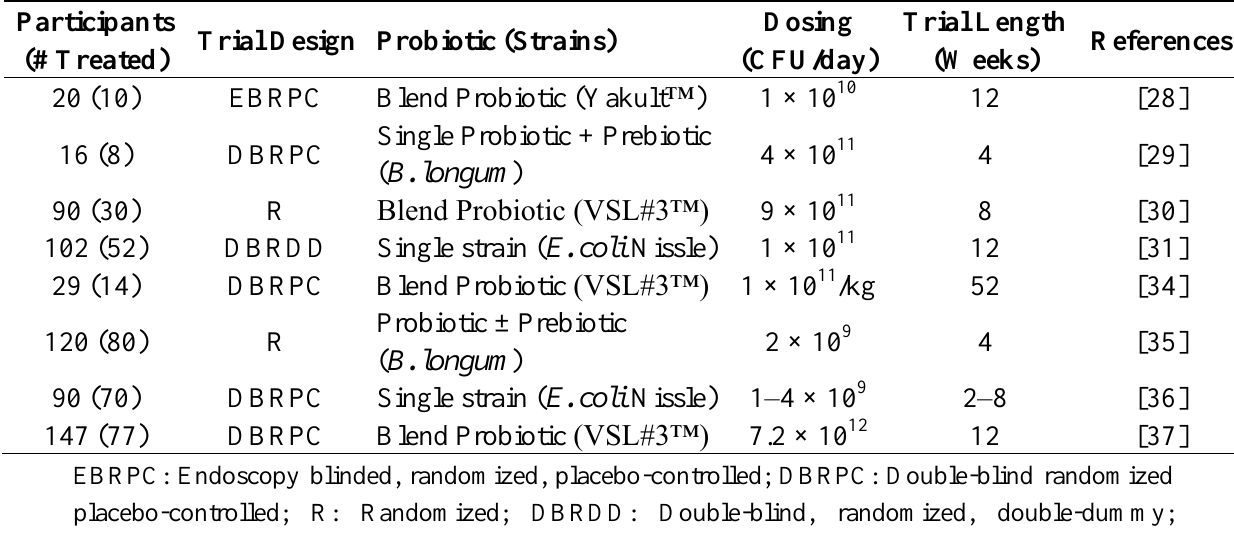
Table 1. Randomized Trials of probiotics as therapy of active